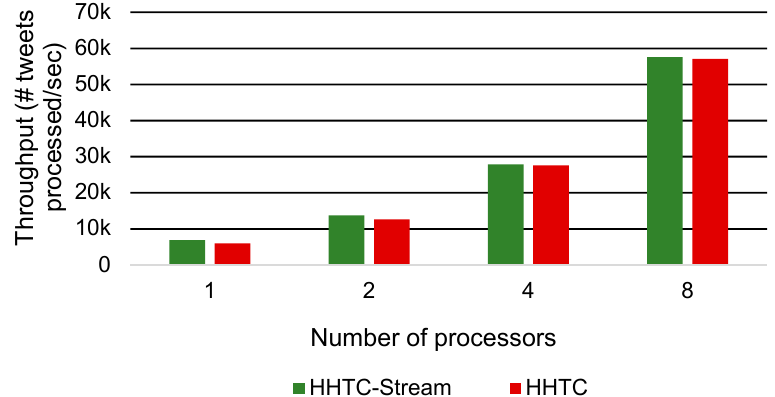
Figure 7. Comparison of throughput with varying number of processors for both HHTC-Stream and HHTC where Throughput is the number of tweets (in thousands) processed per second.